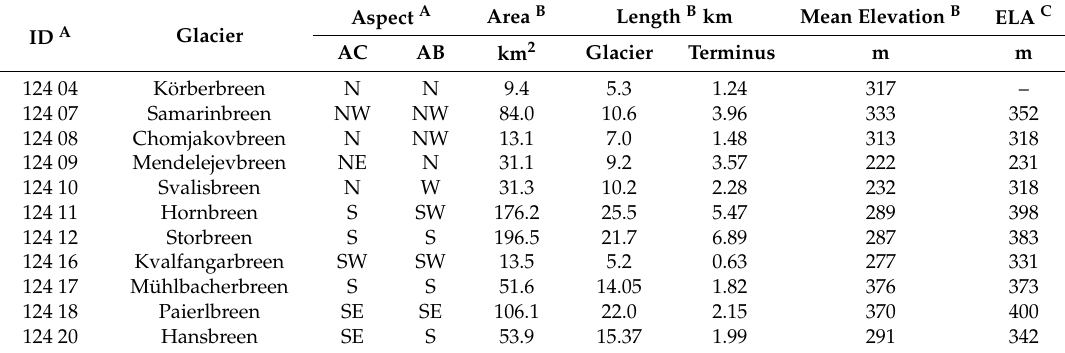
Table 1. Characteristics of selected glaciers on which field measurements were conducted: (AC) accumulation area; (AB) ablation area; (ELA) Equilibrium-Line Altitude.